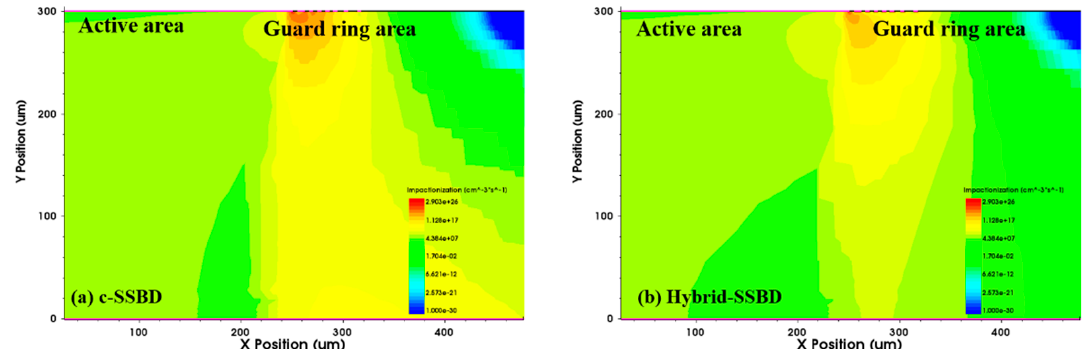
Figure 4. The ionizing impact distribution around the ( a ) c-SSBD and ( b ) Hybrid-SSBD devices; the colors correspond to different strengths of the impact ionization rate. The c-SSBD device had a higher impact ionization rate than the Hybrid-SSBD device at the edge of active area.